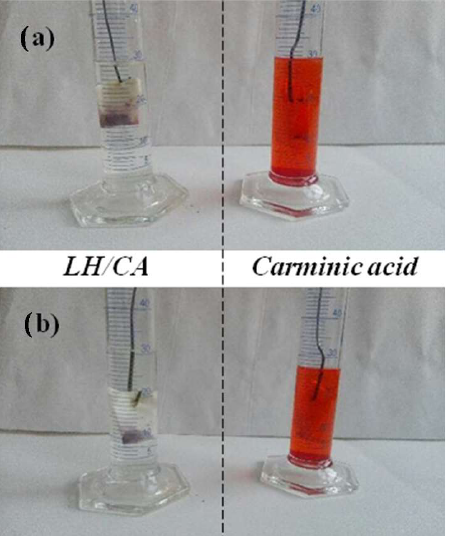
Figure 10. Digital images of carminic acid and LH/CA (20%) after 24 h of immersion in water ( a ) and acetone ( b ).